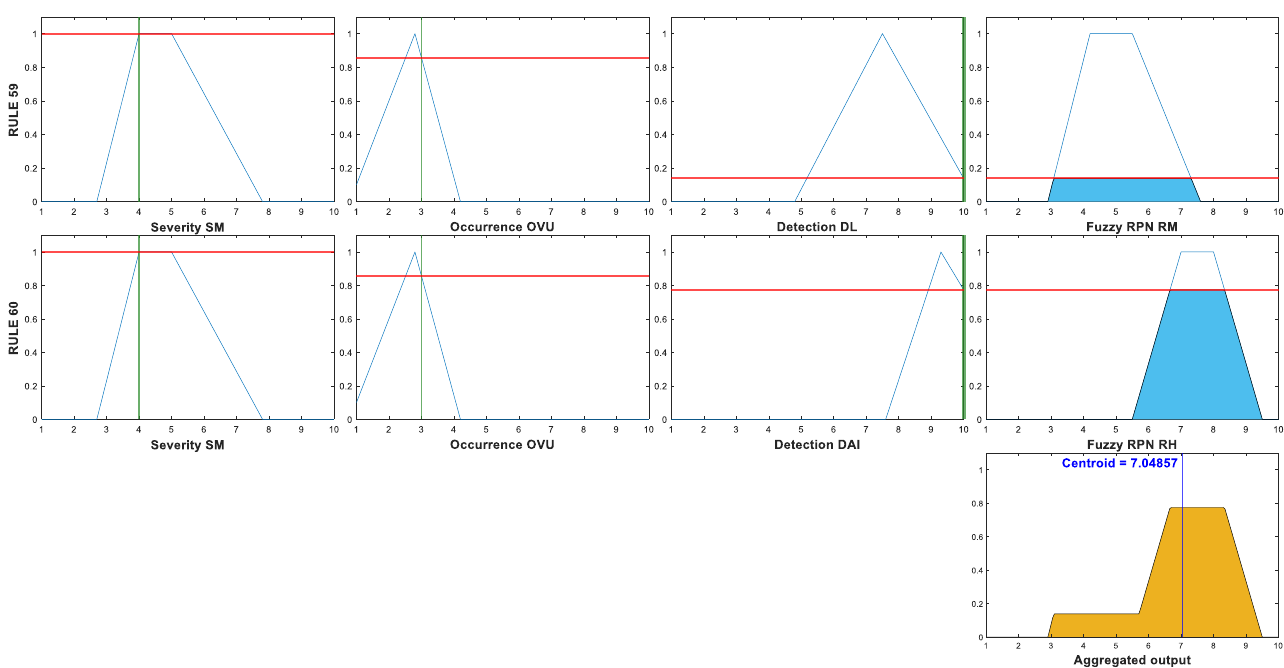
Figure 11. Fired fuzzy rules and aggregated output for failure modes FM41 and FM42.